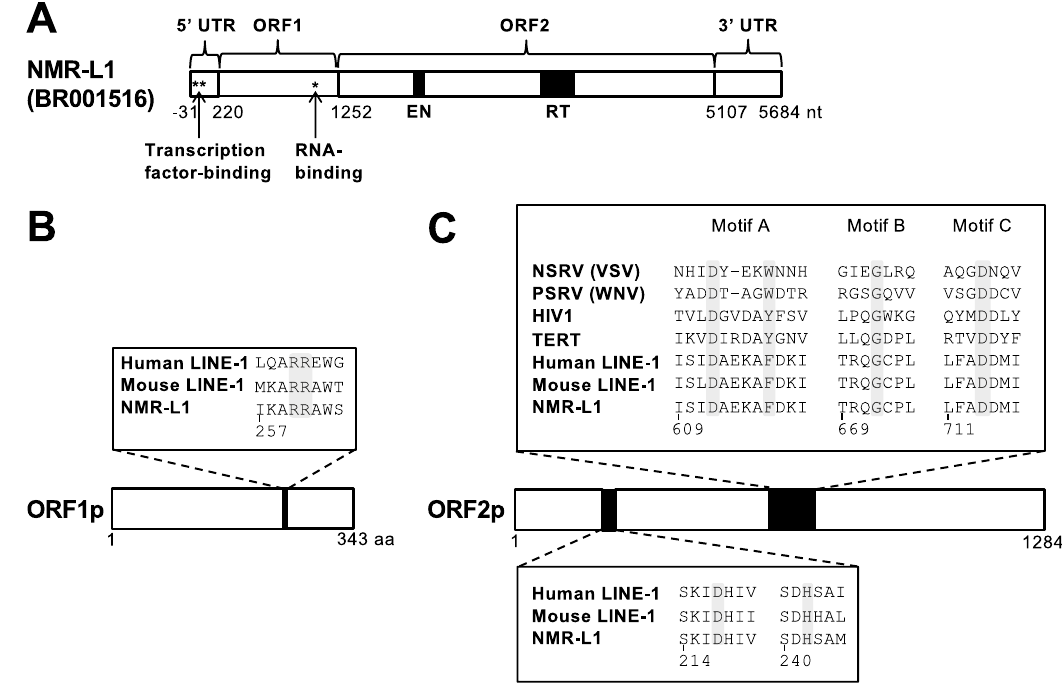
Figure 1. Identification of NMR-L1 from the naked mole-rat (NMR) genome. ( A ) Schematic representation of the NMR-L1 full sequence. Asterisks and black boxes are important regions for the indicated function. EN, endonuclease activity; RT, reverse transcriptase activity. ( B ) Sequence alignment of amino acids important for L1 RNA-binding in the NMR-L1-, mouse L1 spa -encoded, and human L1 RP -encoded ORF1p. ( C ) Sequence